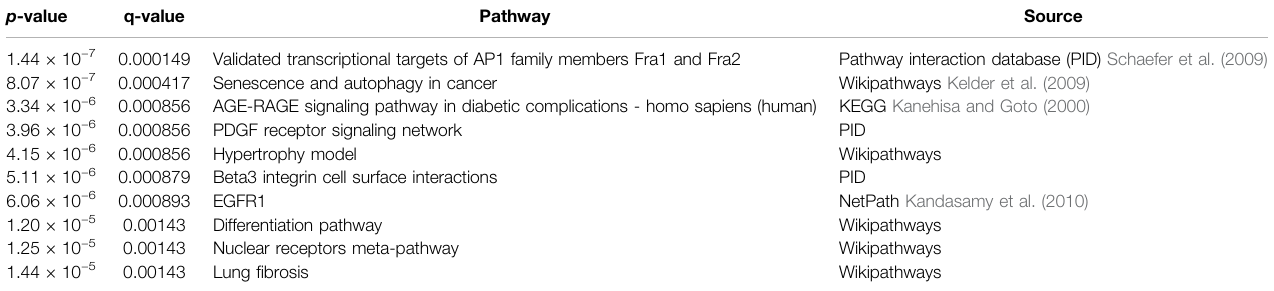
TABLE 2| Overrepresentation analysisusing Consensus PathDB comparingdifferentiallyexpressed genesin ginsenosideRb2/Rg3 combination treated cells tocontrol (10 pathwayswithlowest p -valueareshown).Growthfactor-involvedsignalingpathways,suchasPDGF,EGFR1anddifferentiationpathway,areoverrepresentedaswellas cell survival pathways such as AP1, senescence and autophagy in cancer.